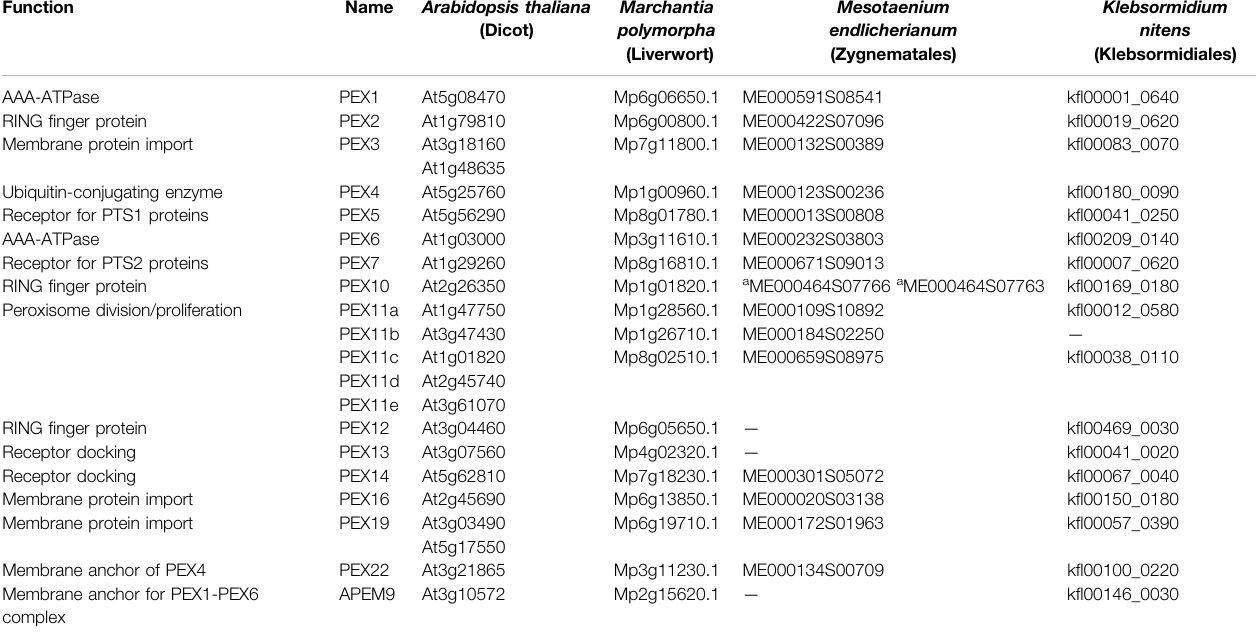
TABLE 2 | PEX genes in representative land plants and algae.